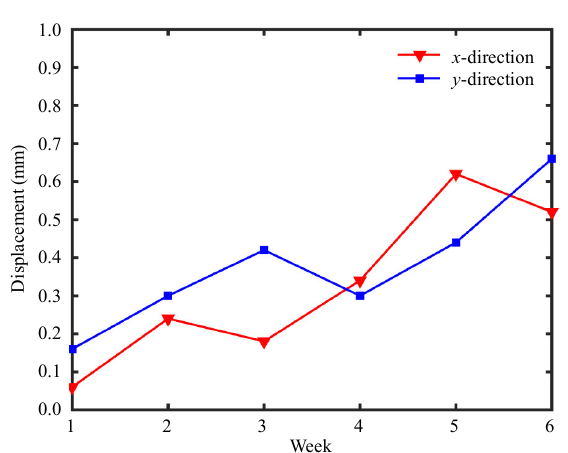
Fig. 16 Displacement curve during the monitoring